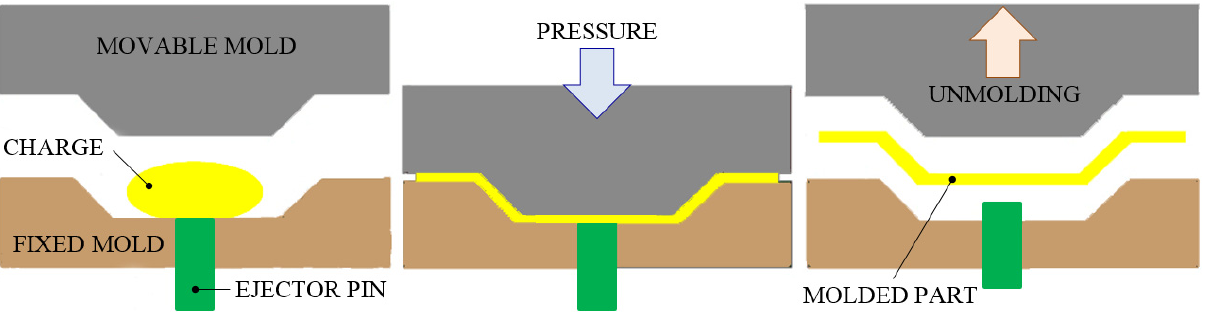
Figure 7. Compression molding process: mold feeding, pressure application, unmolding.